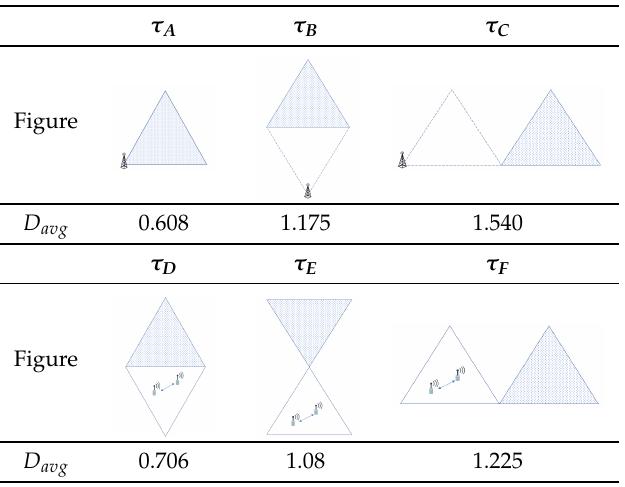
Table 2. Average distance coefficient according to type of neighboring